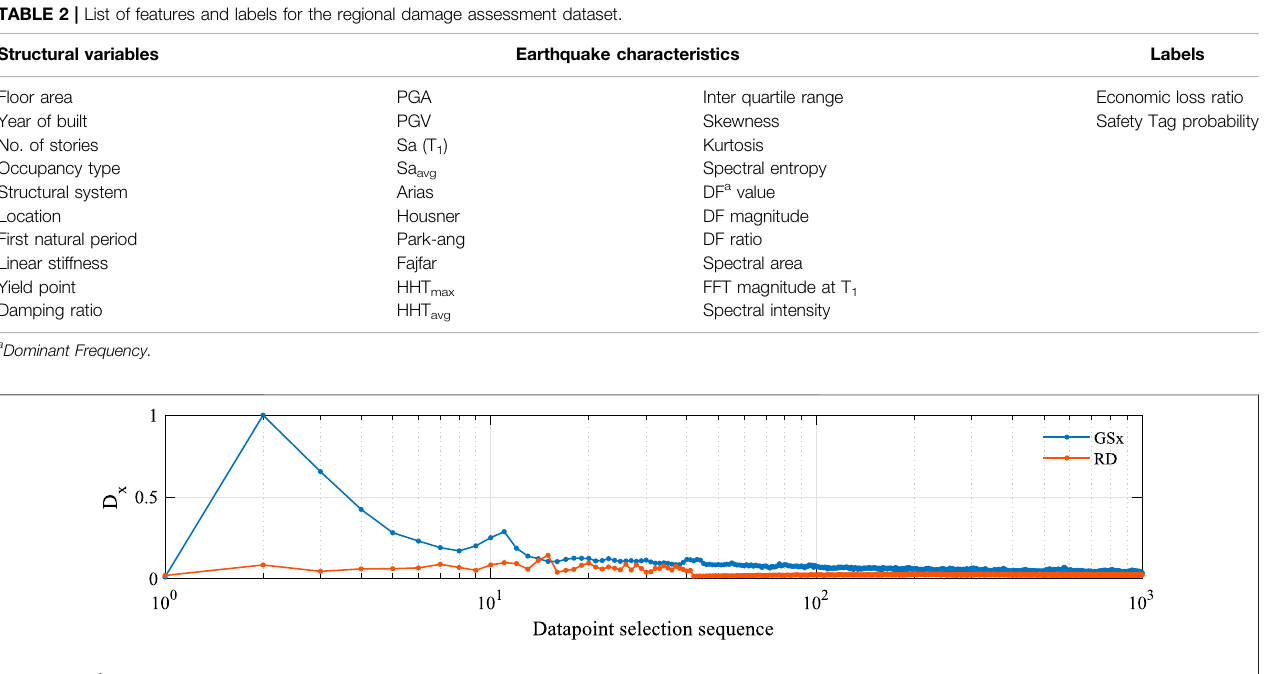
Frontiers in Built Environment |